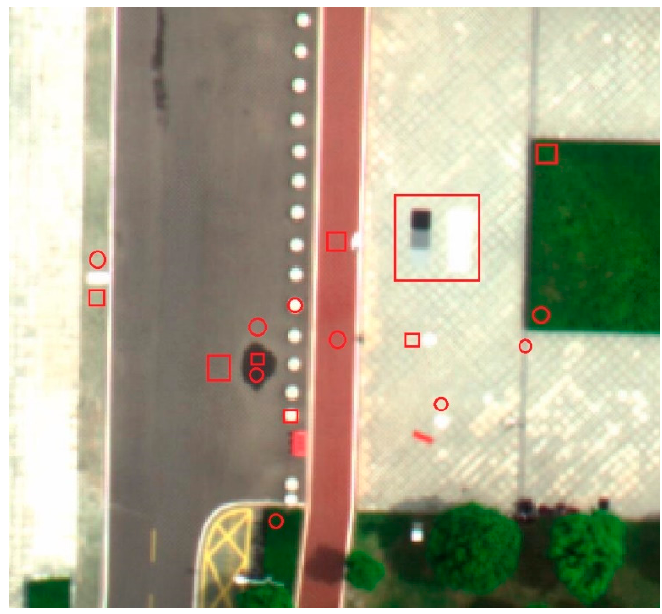
Figure 6. UAV image of the control and check surfaces.